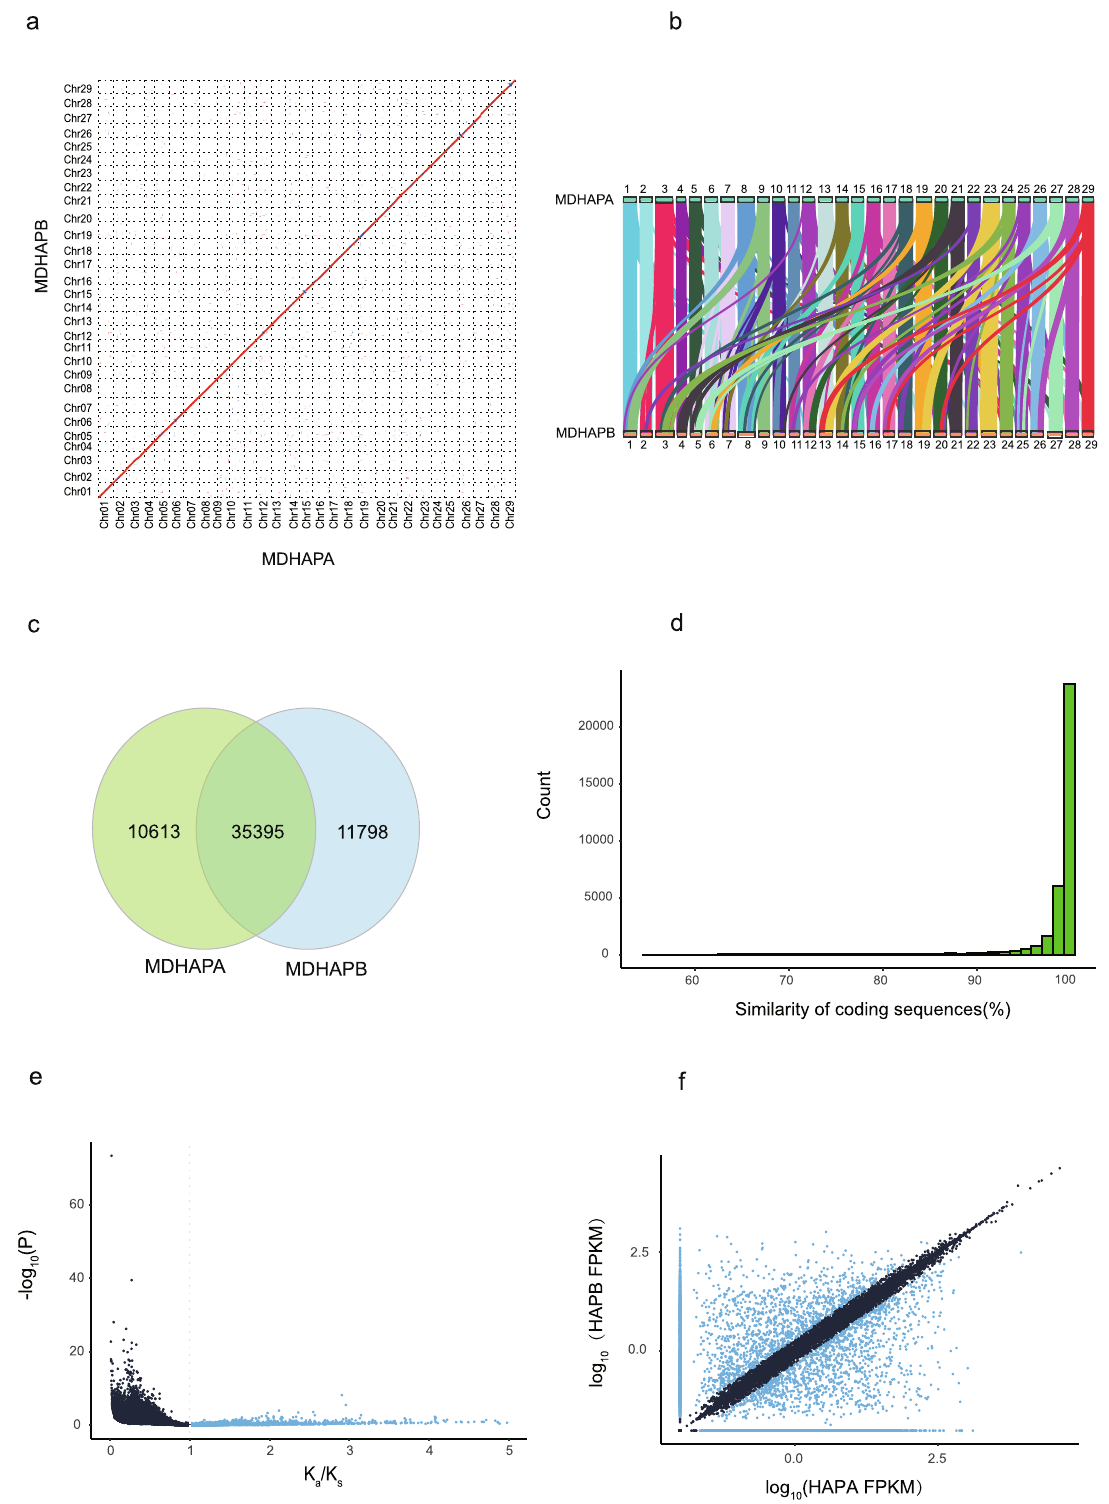
Fig. 2 Comparison of MDHAPA and MDHAPB. a Sequence alignment of MDHAPA and MDHAPB. b The syntenic regions between MDHAPA and MDHAPB. c The number of alleles found whithin genome wide alignmentblocks. d Similarity of coding sequences for alleles. e Pairwise − comparison of the Ka/Ks distribution for allelic genes. f Identification of ASE genes in fruit of DAF 120. Coordinates are logarithmically scaled (log10). Blue dots indicate ASE genes, and gray dots represent genes that are not ASE